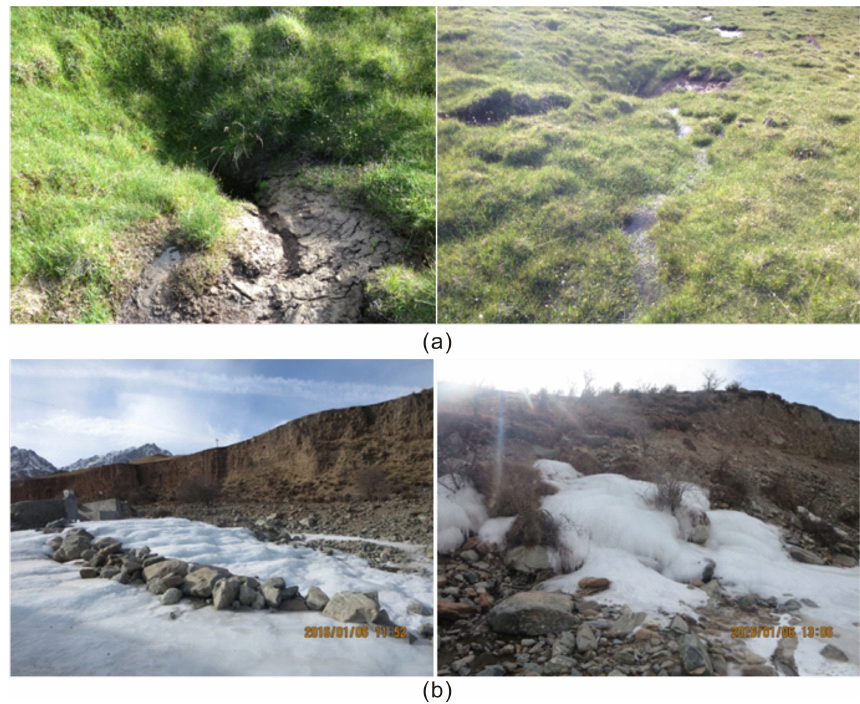
Figure 11. Pictures showing (a) sinkholes in the permafrost zone, (b) stream icing within the gorge (left) and spring icing on the hill slope (right) during cold